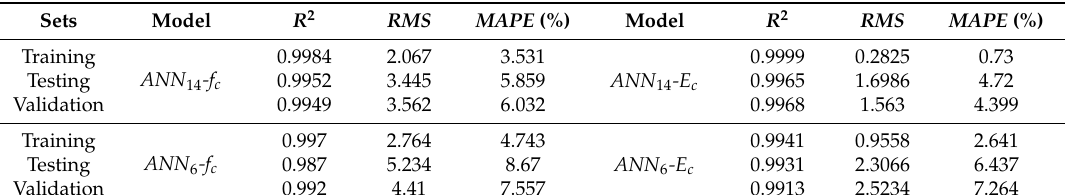
Table 4. Performance of ANN models. MAPE : the mean absolute percentage error; RMS: root-mean- squared error.